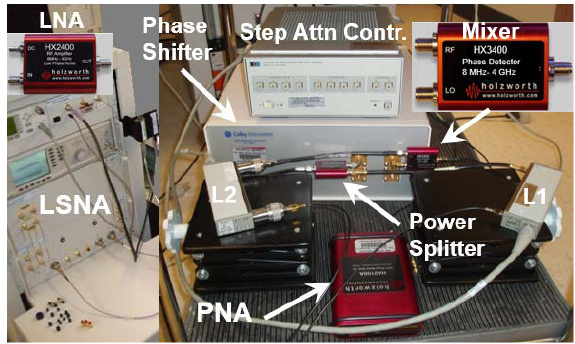
Figure 4. Testbed used for the measurement of additive phase